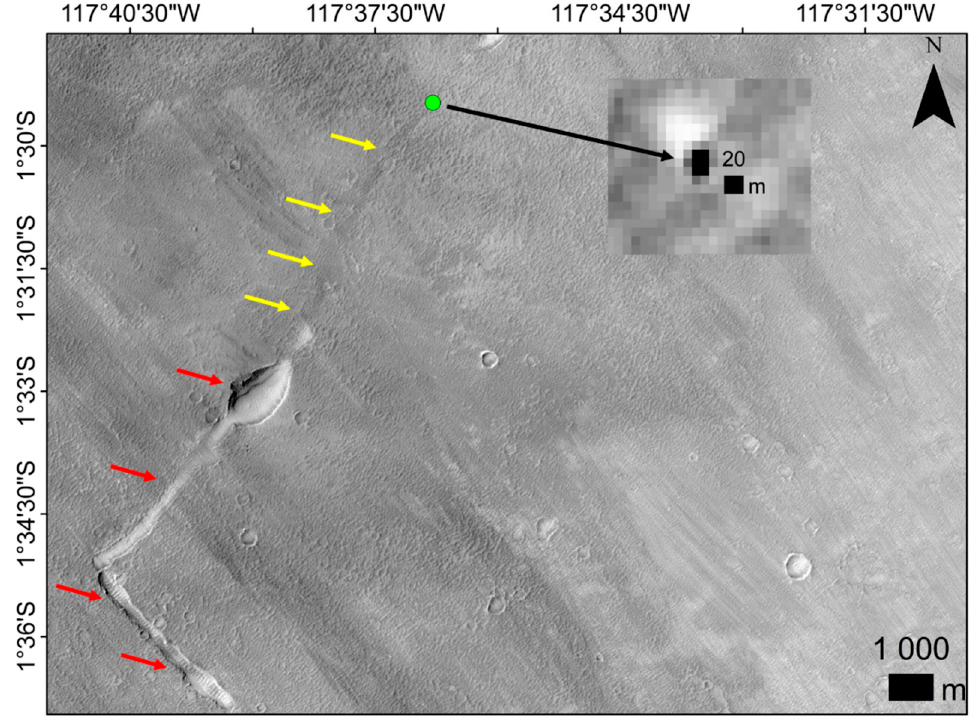
Figure 13. A possible small subsidence cave opening in a lava tube (CTX Scene ID: G18_025285_1769_XN_03S117W). The red arrows mark the collapsed part of the lava tube and a possible fissure while the yellow arrows mark the intact part. The green dot marks the possible cave opening that can be seen in the zoomed-in version indicated by the black arrow. CTX image credit: NASA/JPL-Caltech.